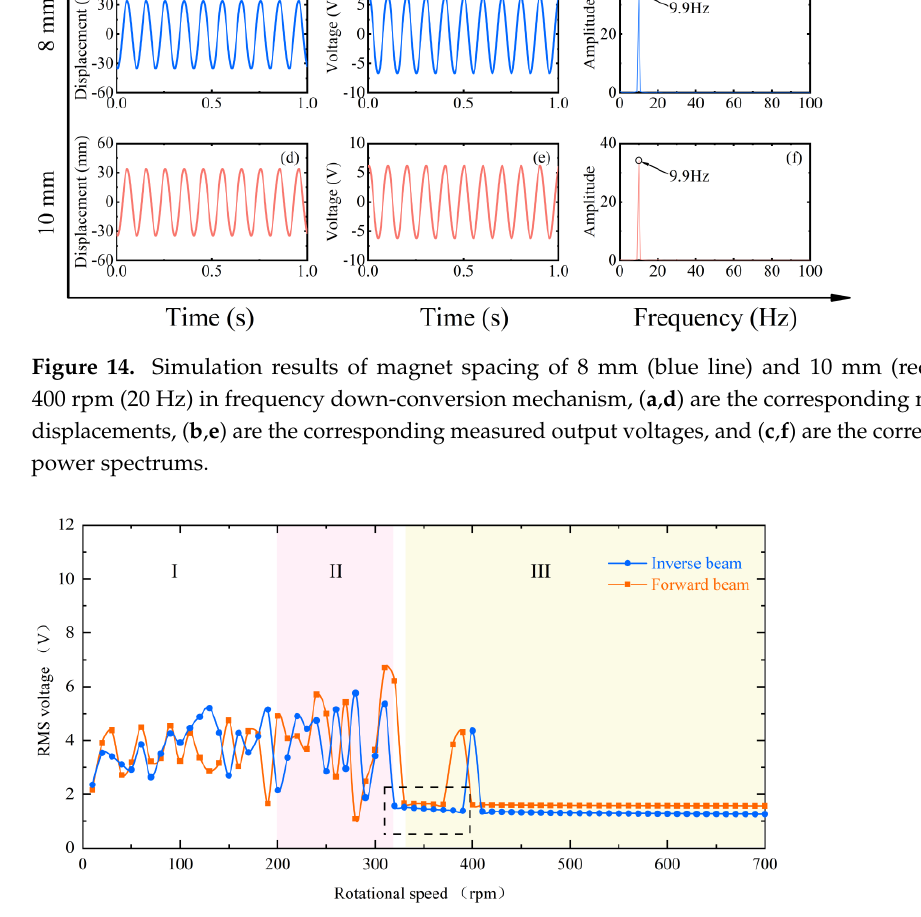
Figure 15. Simulation results of the RMS voltage comparison between the inverse beam (blue line) and forward beam (red line) at 10 mm magnet spacing.